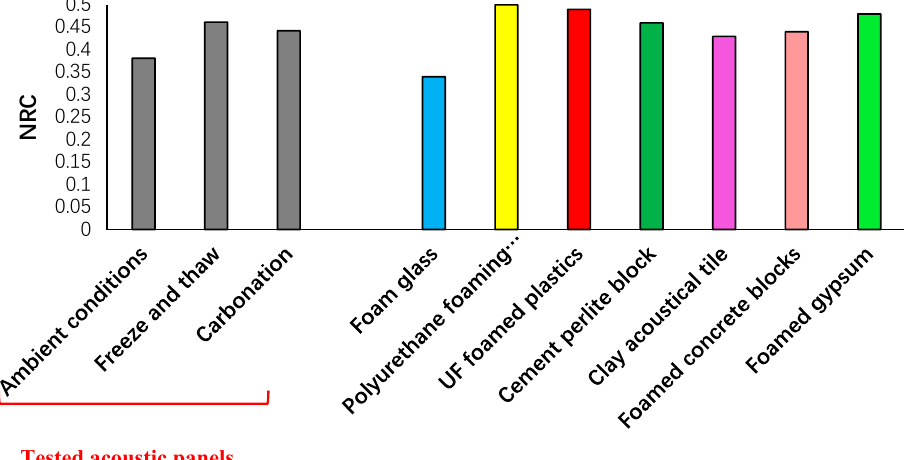
Figure 14. Noise reduction coefficients (NRCs) in the developed acoustic panels and other foamed materials reported in Reference [40].